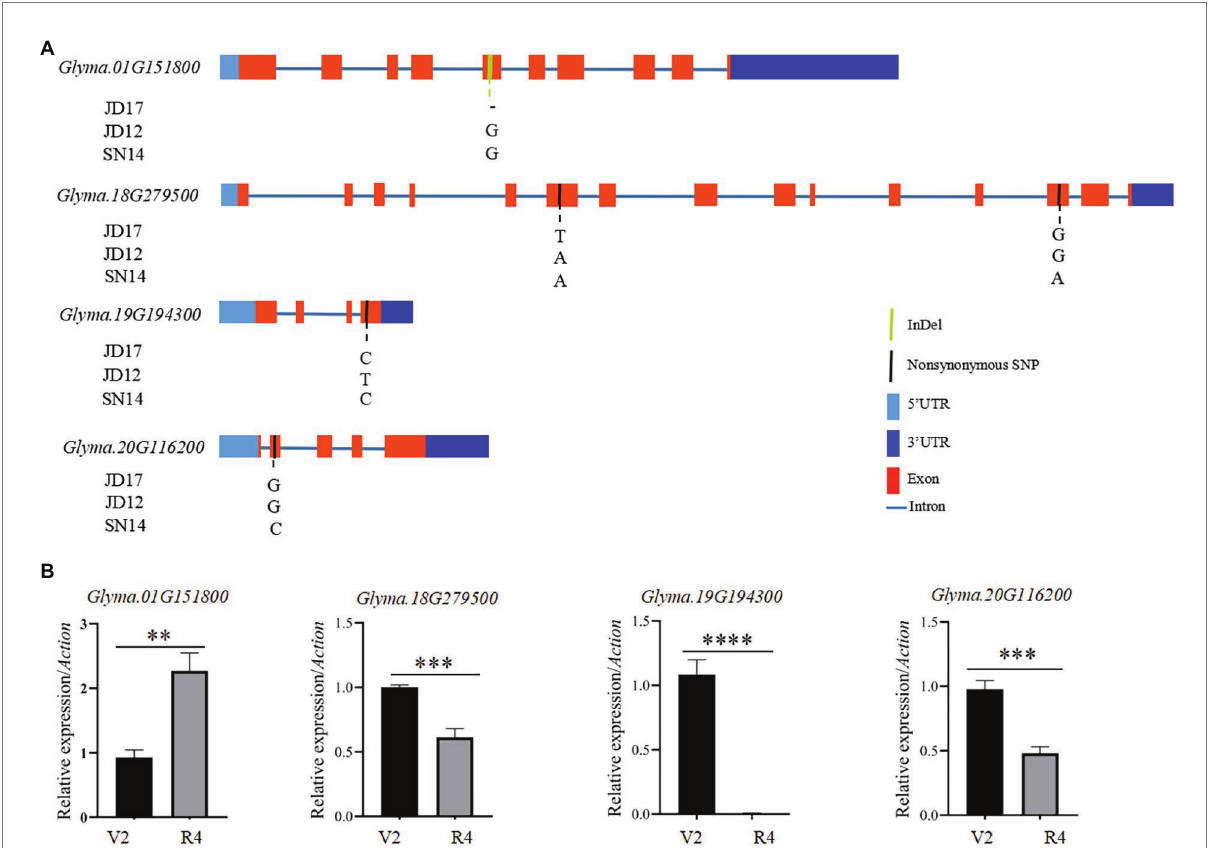
FIGURE 4 Sequence differences of the four candidate genes among the three parental genotypes and their transcript levels at different developmental stages of JD17. (A) Gene structures and genome sequence alignments (non-synonymous SNPs) of the four candidate genes among the three parental genotypes; and (B) Expression of the four candidate genes at vegetative growth stages V2 and R4 in JD17. **indicates significant difference at p < 0.01, ***significant at p < 0.001, and ****significant at p < 0.0001.